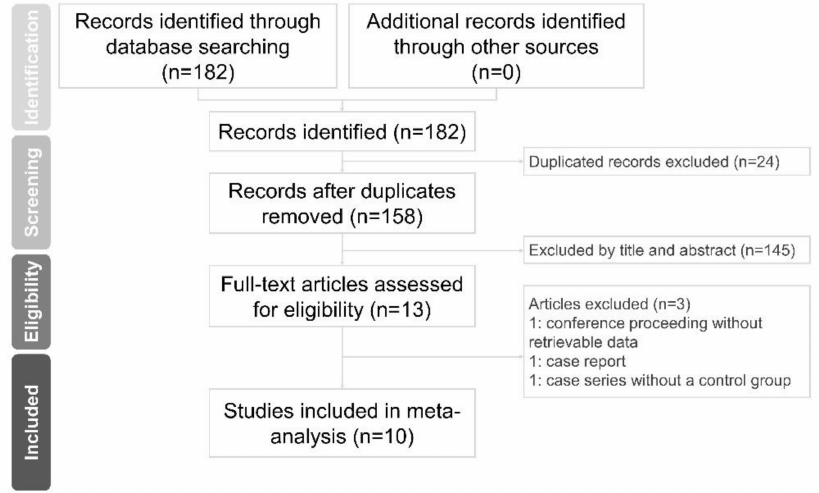
Figure 1. Flow diagram showing the study selection process based on the suggested format in the PRISMA (Preferred Reporting Items for Systematic Reviews and Meta-Analyses)